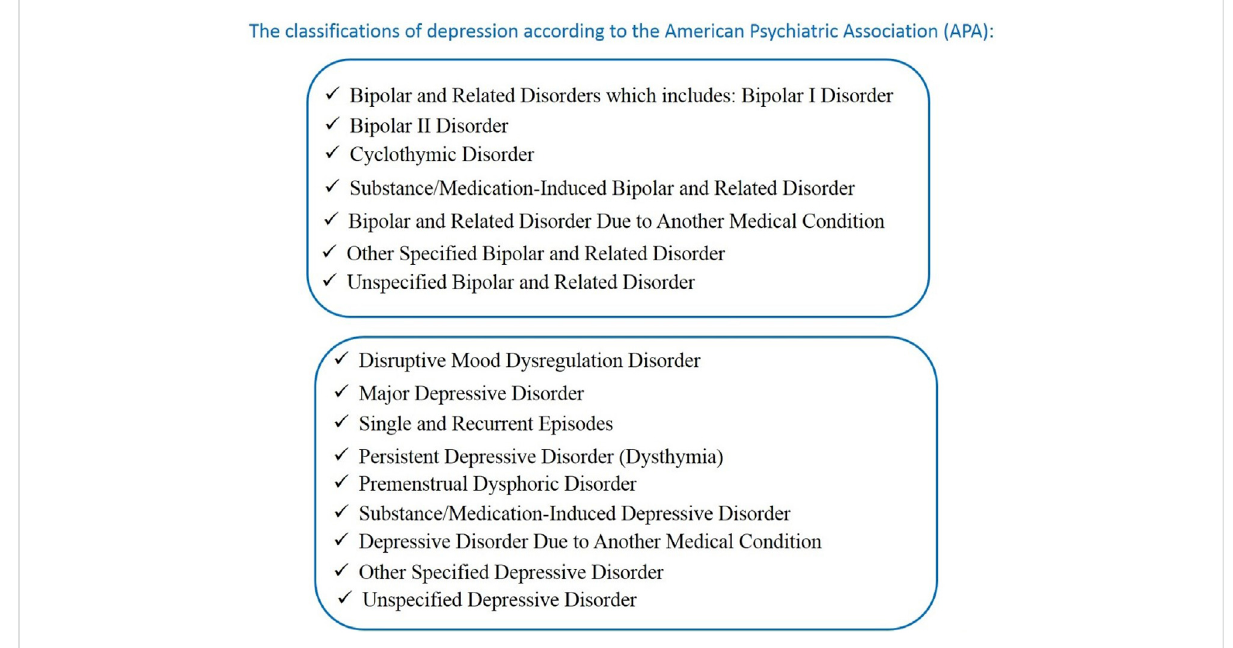
FIGURE 1 The classi fi cation of depression according to the American Psychiatric Association (APA). (DSM-5, 2013; Uher et al., 2014; Abdel-Bakky et al.,